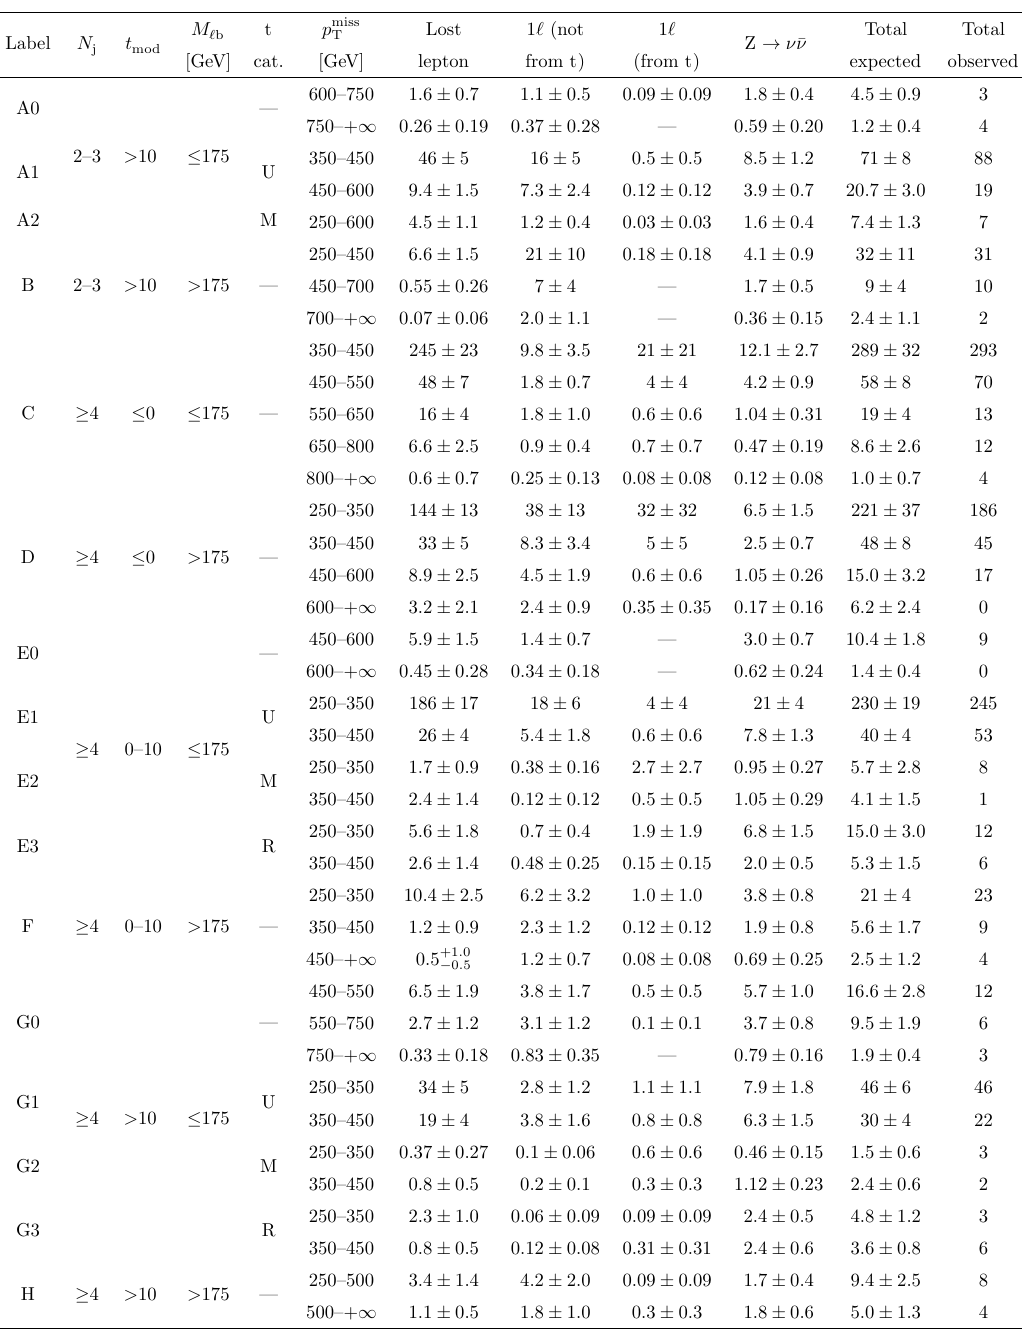
Table 7 . The observed and expected yields in the standard search regions. For the top quark tagging categories, we use the abbreviations U for untagged, M for merged, and R for